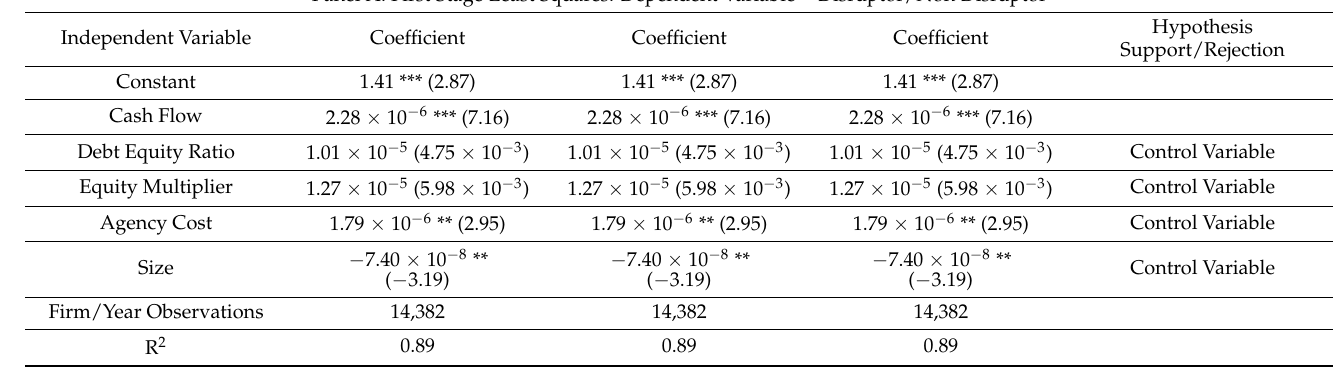
Table 3. Two-Stage Least Squares Regressions of Cash Flow on Disruption, Followed by Disruption on Financial Performance (Full